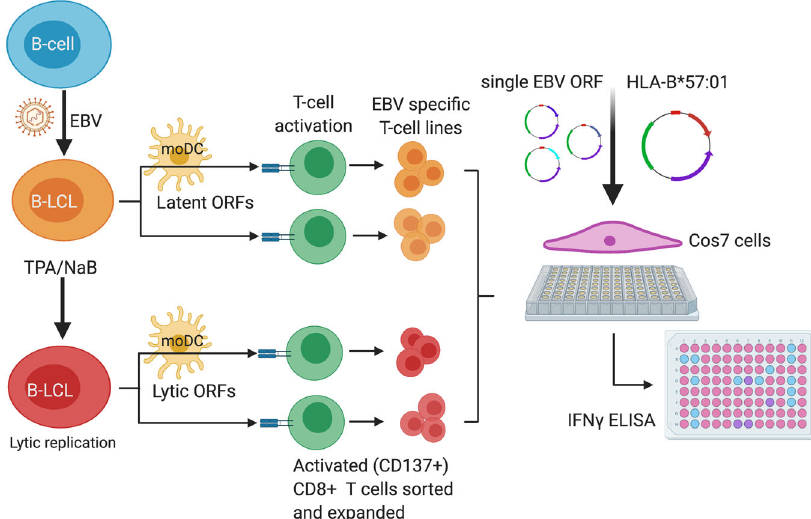
Fig. 1 Schematic overview of the production of EBV-speci fi c CD8 + T cell lines and their use to de fi ne HLA-B*57:01 restricted EBV epitopes. To produce EBV-speci fi c CD8 + T cell lines, autologous LCLs were fi rst produced by the infection of B cells with EBV. Autologous LCLs were incubated with donor derived CD8 + T cells from PBMCs to identify EBV-speci fi c T cells via the up-regulation of CD137. Flow sorted EBV-speci fi c CD8 + CD137 + T cells were non- speci fi cally expanded by one round of PHA stimulation followed by a second round of anti-CD3. Alternatively, stimulatory LCLs were pre-treated with TPA and NaB to induce lytic replication of EBV and permit the detection of epitopes encoded by lytic ORFs. EBV-speci fi c T cells were also identi fi ed in the presence of autologous moDC in LCLs or lytic phase induced LCLs to determine if this allowed for cross presentation and therefore the detection of a broader T cell repertoire. Altogether, four EBV-speci fi c T cell lines were generated from each donor. To determine the EBV speci fi cities of each T cell line, Cos-7 cells were cotransfected with plasmid expressing a single EBV ORF and plasmid expressing HLA-B*57:01. The transfected Cos-7 cells were cultured with each EBV-speci fi c CD8 + T cell line for 48 h. HLA-B*57:01 restricted T cell speci fi city was determined by IFN γ ELISA of the culture